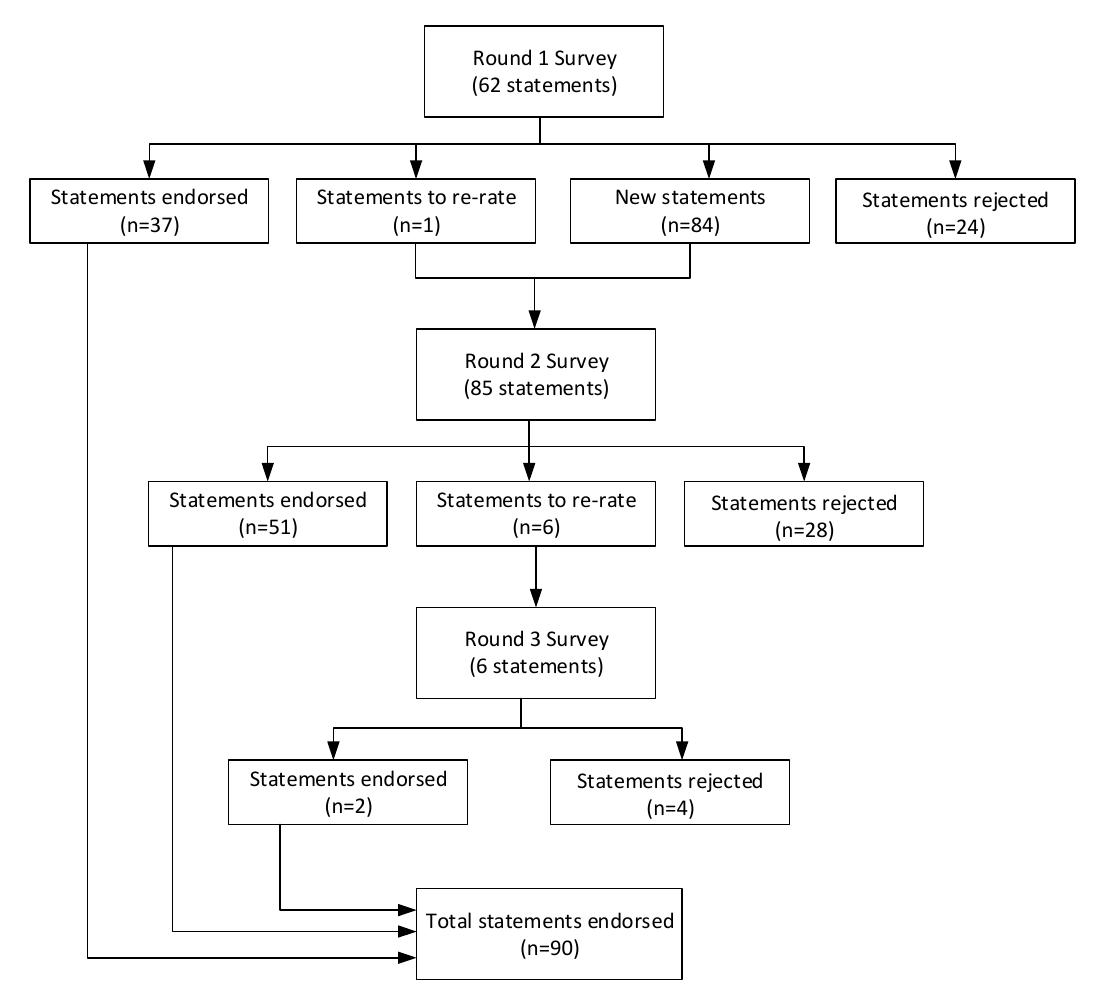
Figure 1. Number of statements that were endorsed, rejected and presented for re-rating at each survey round.